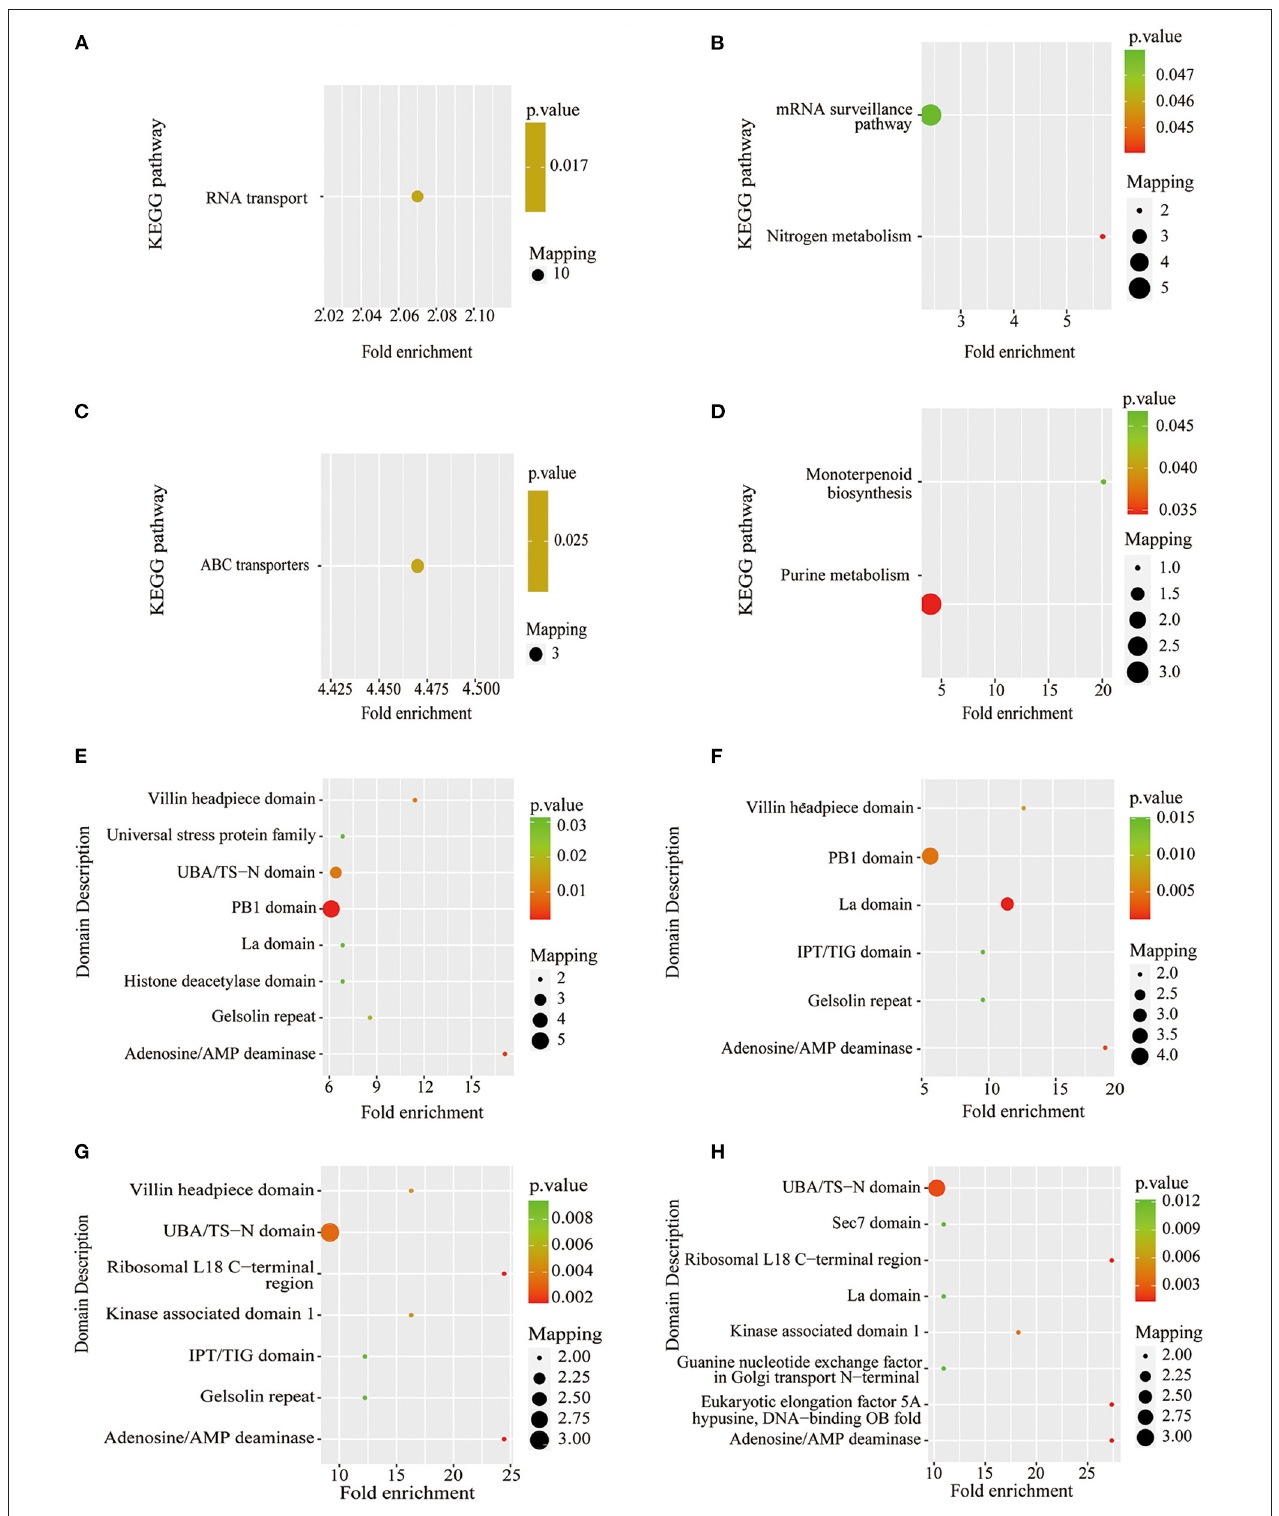
FIGURE 7 | KEGG pathway-based enrichment analysis and protein domain enrichment analysis of Pi starvation and resupply. (A) KEGG pathway-based enrichment analysis of P6/CK; (B) KEGG pathway-based enrichment analysis of P48/CK; (C) protein domain enrichment analysis of R6/CK; (D) KEGG pathway-based enrichment analysis of R48/CK; (E) protein domain enrichment analysis of P6/CK; (F) protein domain enrichment analysis of P48/CK; (G) protein domain enrichment analysis of R6/CK; (H) protein domain enrichment analysis of R48/CK. KEGG, Kyoto Encyclopedia of Genes and Genomes.